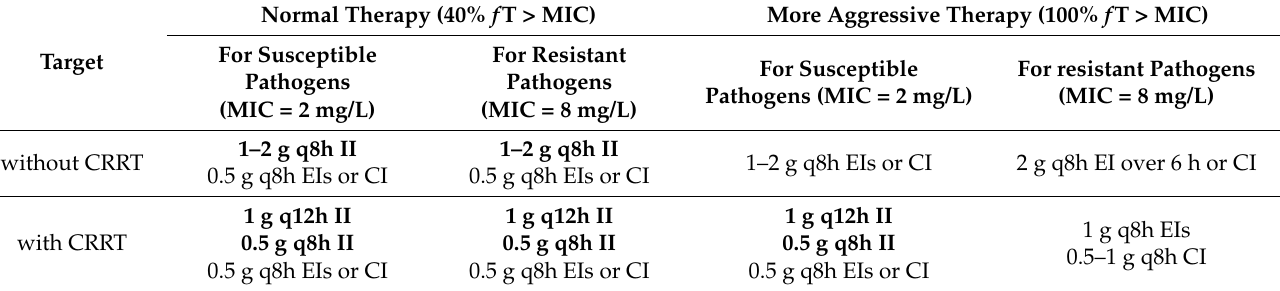
Table 3. Recommended dose regimen for